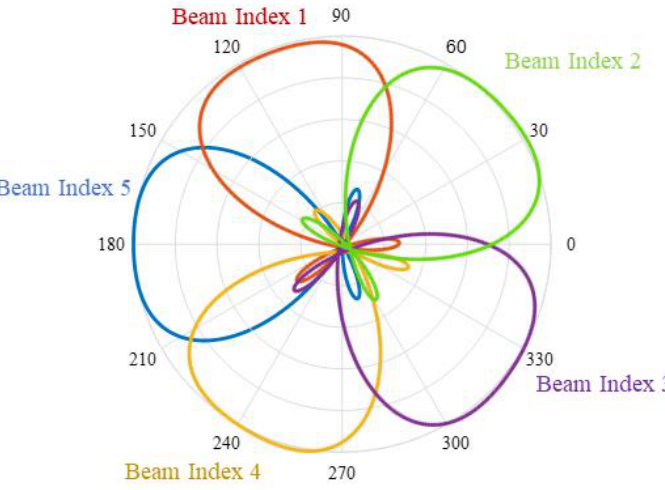
Figure 3. Beam indices at the MS.